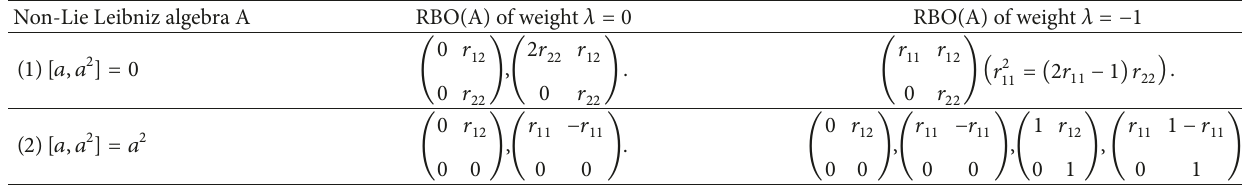
Non-Lie Leibniz algebra A RBO(A) of weight 𝜆 = 0